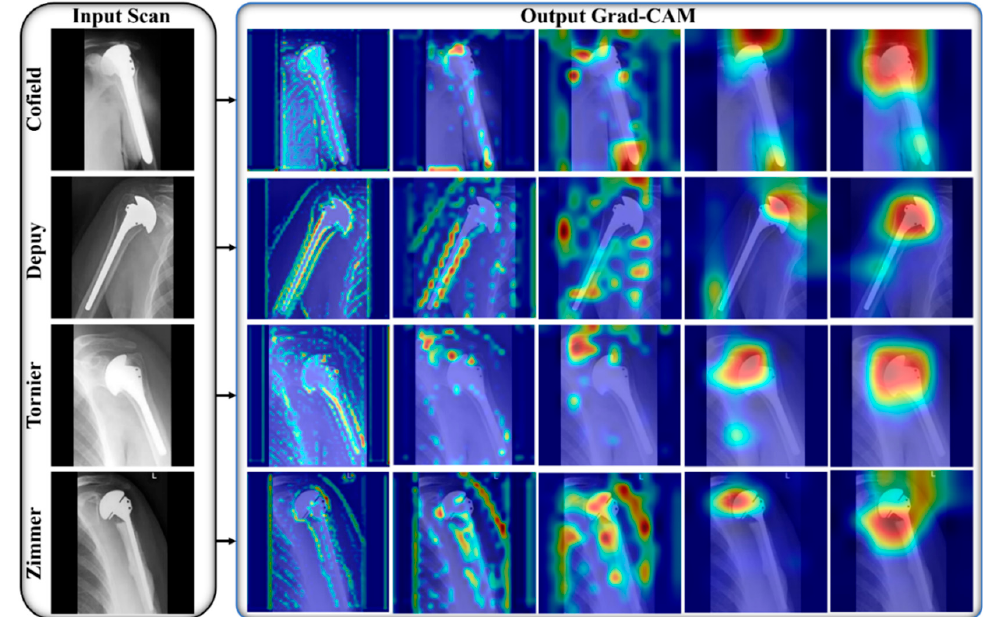
Figure 6. Visual explanation maps of MFC-Net for all manufacturers. The 1st to 5th Grad-CAM images are, respectively, obtained from the 1st Block B, 2nd Block B, 3rd Block B, 5th Block B, and last Block A in Table S3.